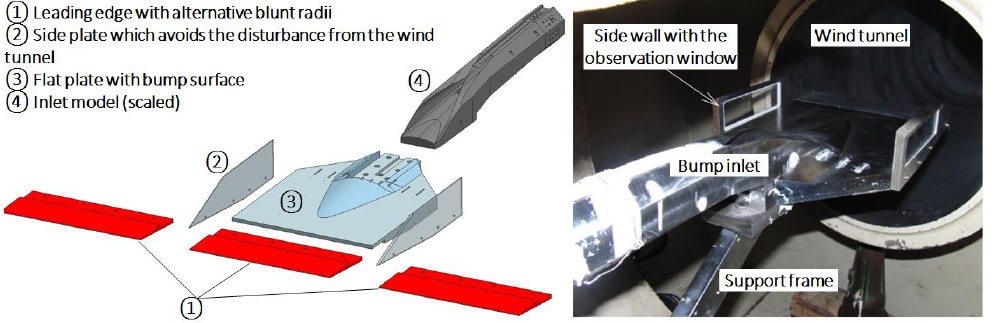
Figure A1. Schematic ( left ) and installation view ( right ) of a central-spillage diverterless hypersonic inlet.